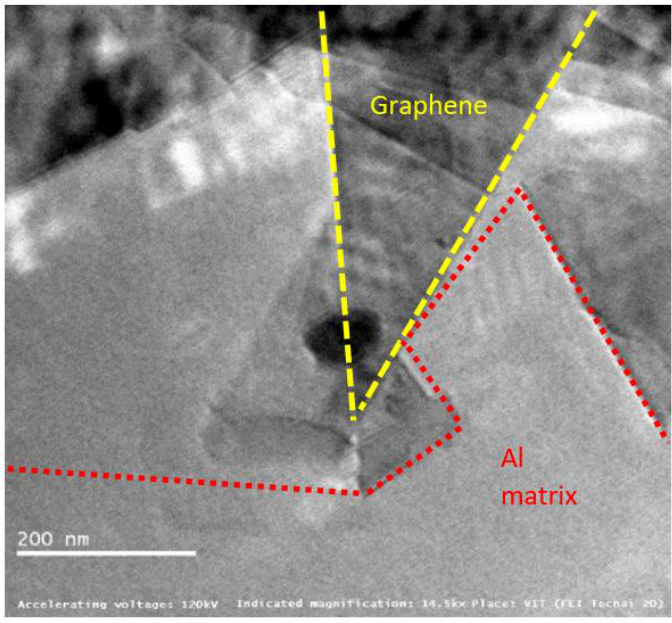
Figure 16. Graphene sheets embedded in AA2024 at 14.5 kX.